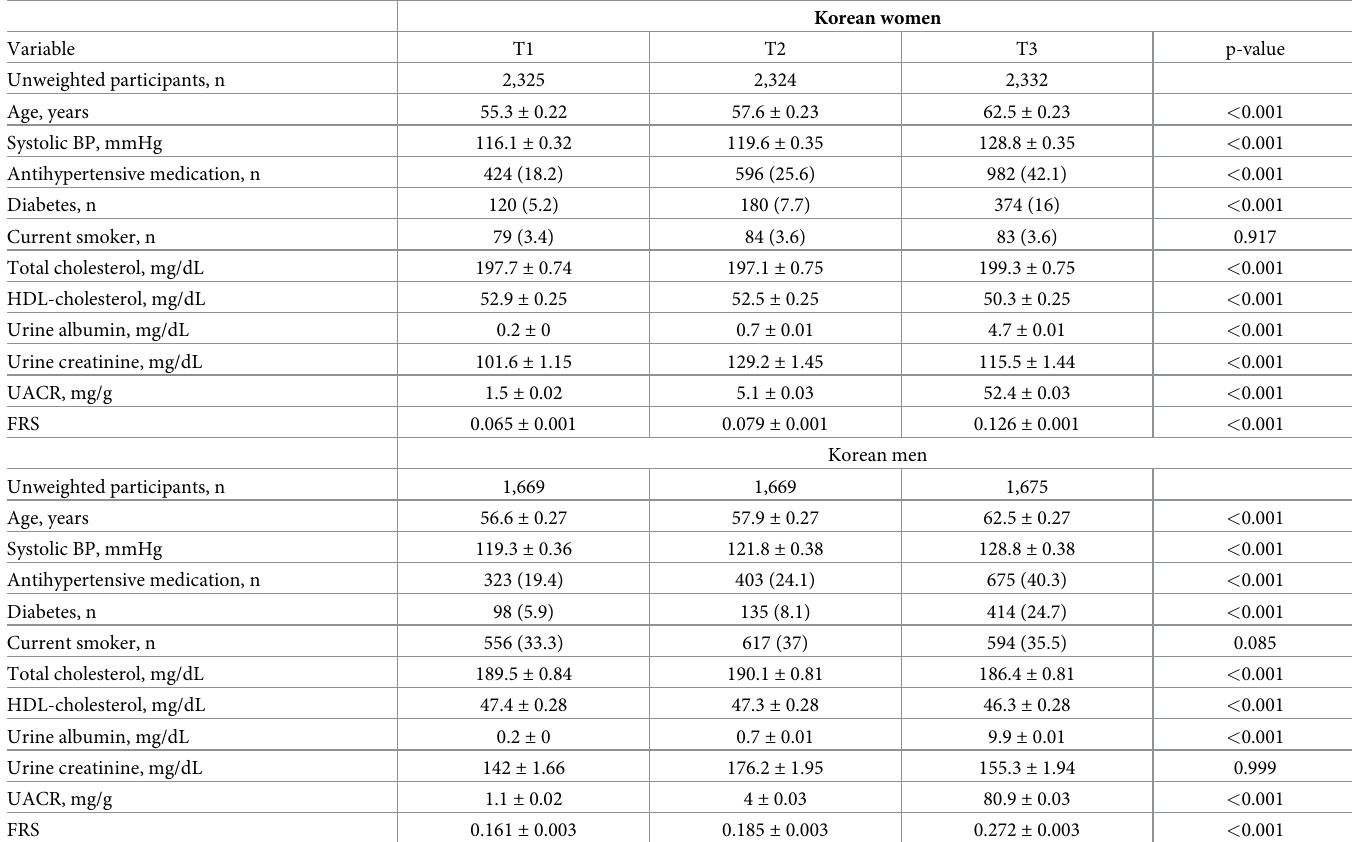
Table 1. Sex-specific characteristics according to UACR